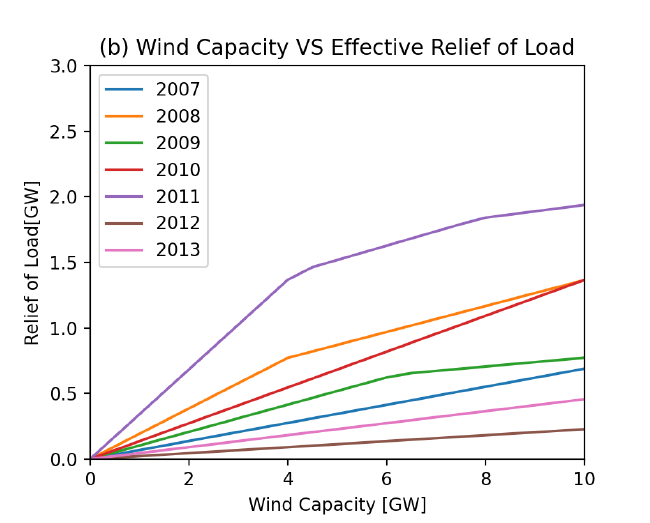
Figure 15. Relief of load covered by capital from ( a ) solar, and ( b ) wind installation.